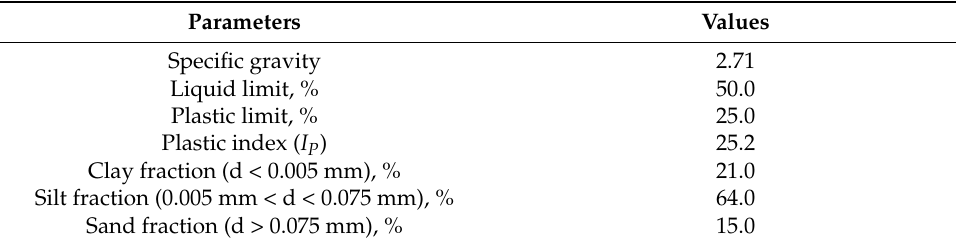
Table 1. Physical characteristics of dredged sediment.